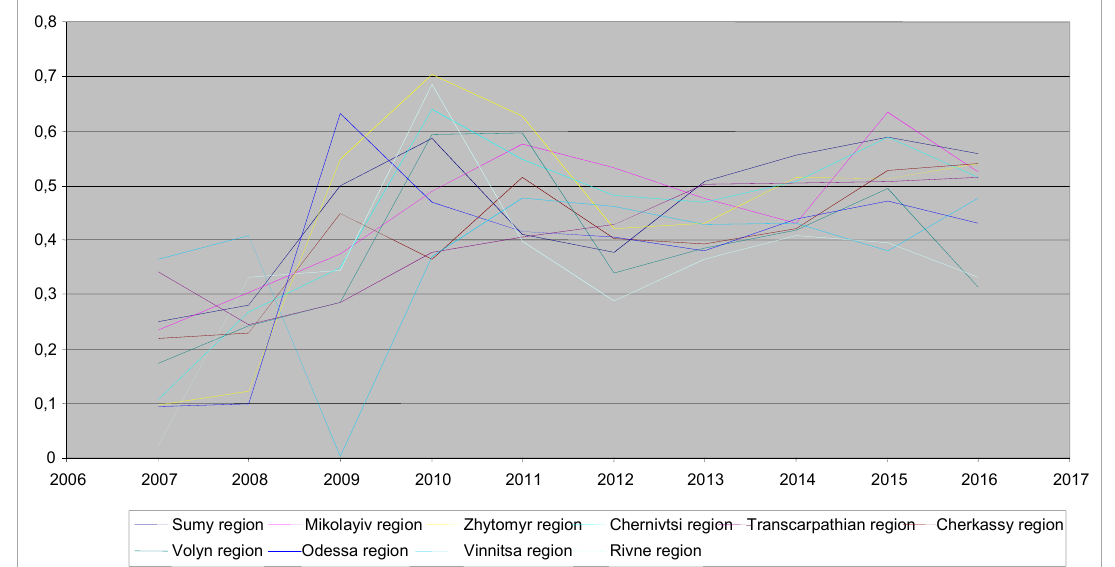
Fig. 2. Dynamics of the modified level of regional development with an average value of the integral indicator from 0.35 to 0.5